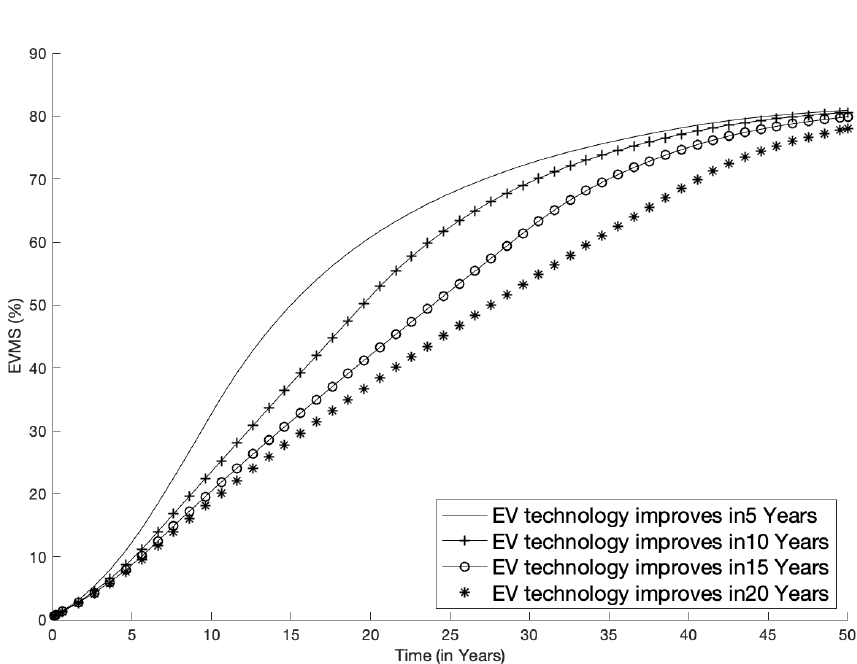
Figure 5. EVMS for different technology improvement